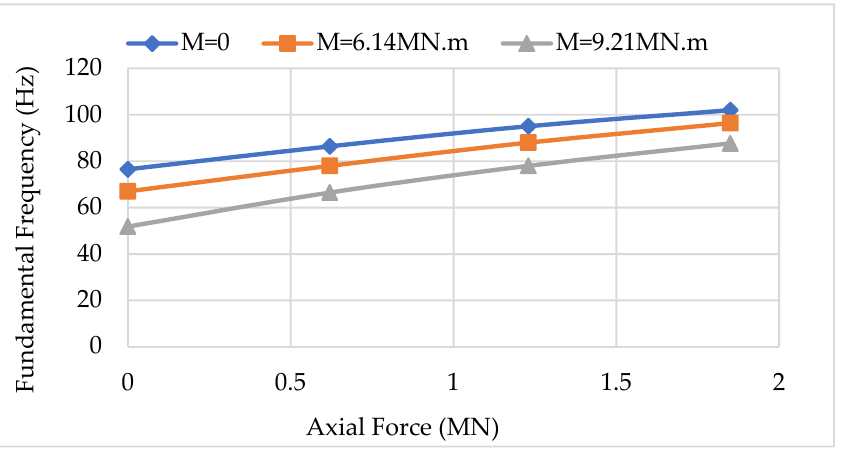
Figure 7. Fundamental frequency of cantilevered, preloaded, three-layer, unidirectional composite beam (Layup 1) obtained from a 5-element LBDFE model, subjected to various axial loads and end moments.